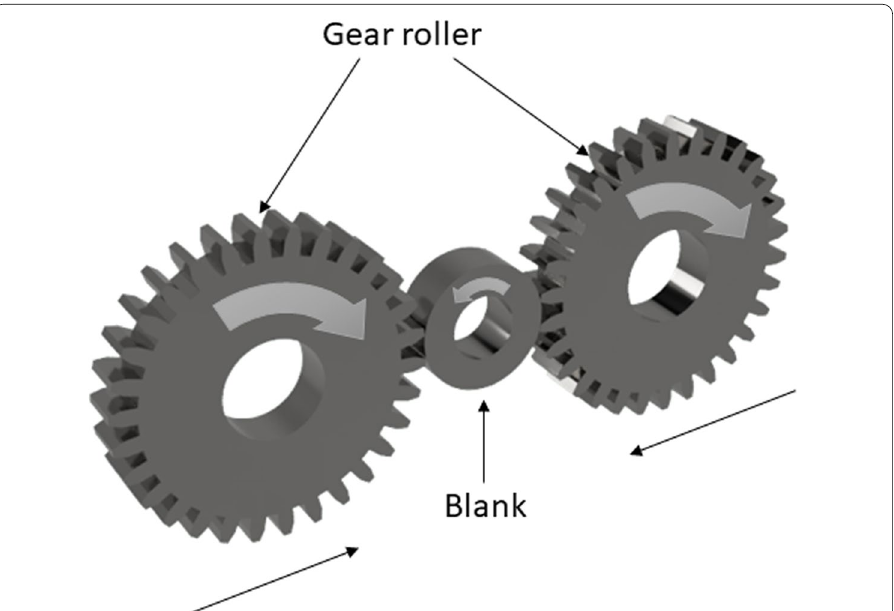
Fig. 8 Cold forming process illustrating reverse threading pattern on